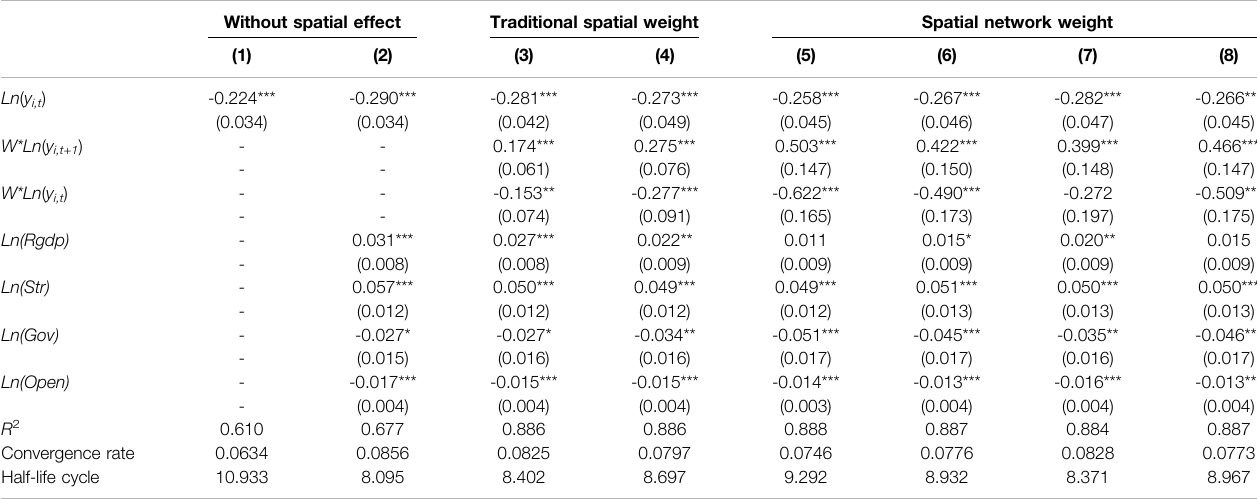
TABLE 3 | Convergence results of the green economic ef fi ciency in the